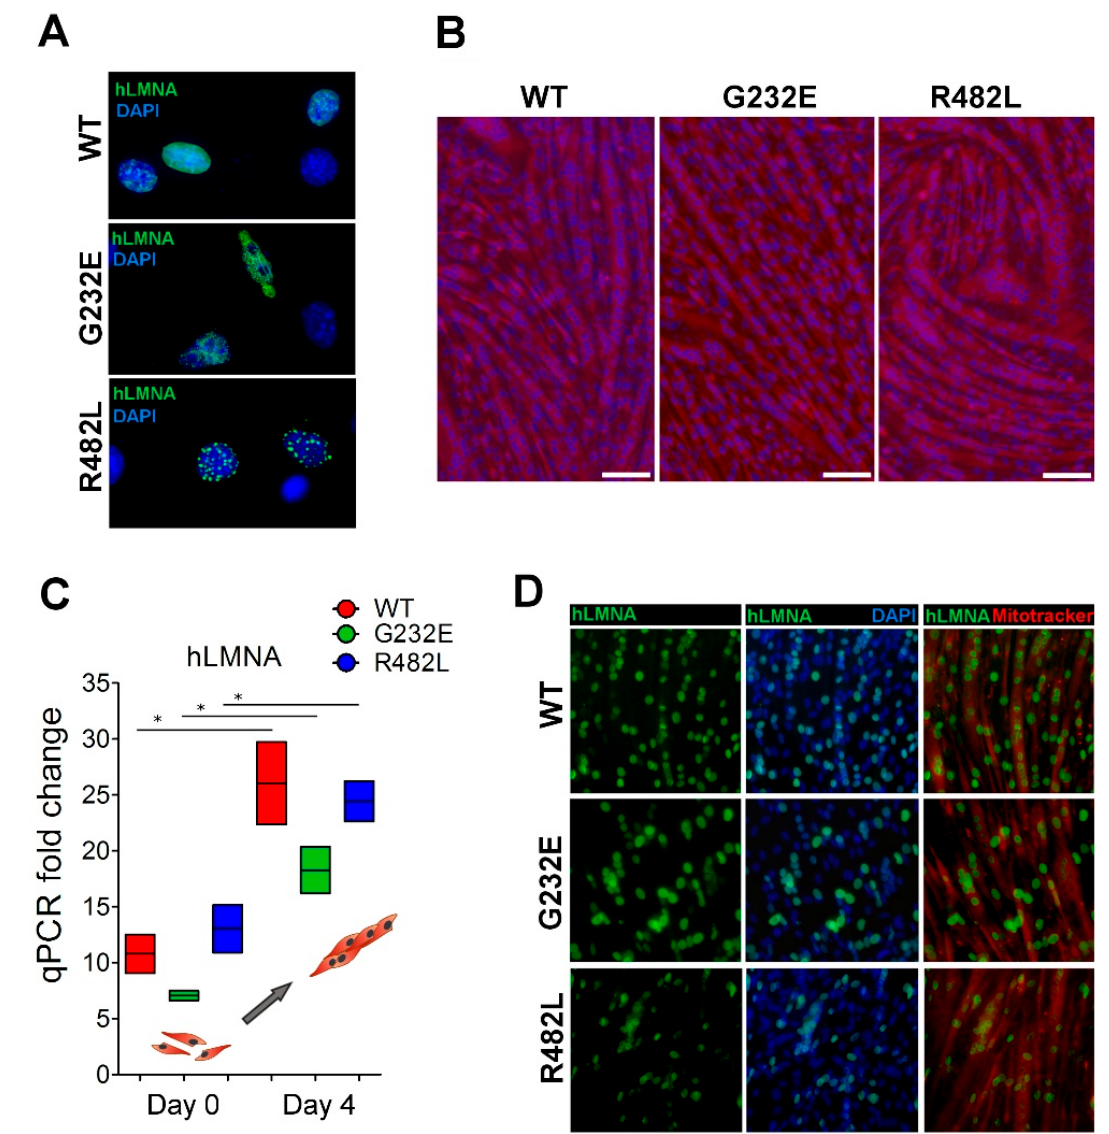
Figure 1. Validation of experimental model: ( A ) Verification of transgene hLMNA expression in C2C12 mouse myoblasts: the cells were stained with anti lamin A antibody recognizing only human lamin A. LMNA G232E/R482L shows aggregates and nuclear blebbing in some of the transduced cells as a result of the mutation; ( B ) stimulation of myogenic differentiation resulted in myotubes formation in all transgene lines (scale bar = 200 µm); ( C ) hLMNA mRNA expression tested in transgene C2C12 myoblasts and in differentiated myotubes ( n = 3; * p < 0.05); ( D ) nuclei in myotubes demonstrate hLMNA-positive staining (scale bar = 100 µm).